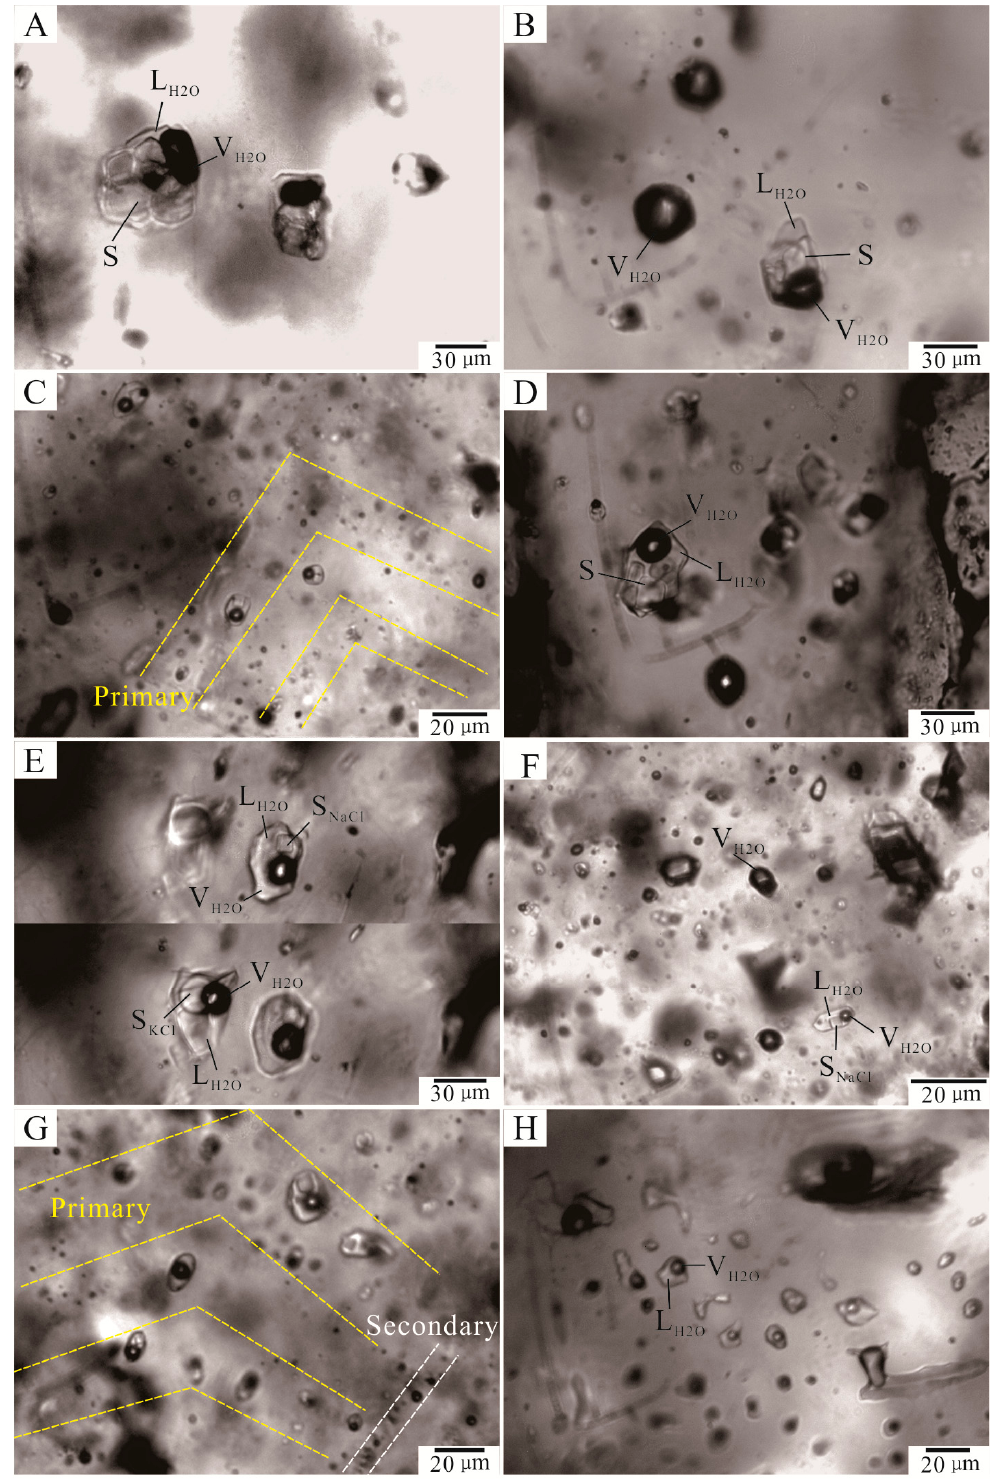
Figure 7. Photomicrographs of fluid inclusions in Stage 1–3 quartz crystals from the Jinchang gold–copper deposit. ( A – D ) S 1 -, S 2 -, and V-type FIs in Stage 1 quartz grains; ( E , F ) S 2 -, V-, and LV-type FIs in Stage 2 quartz grains; ( G , H ) S 2 - and LV-type FIs in Stage 3 quartz grains. Abbreviations: L, liquid phase; V, vapor phase; S, daughter mineral.